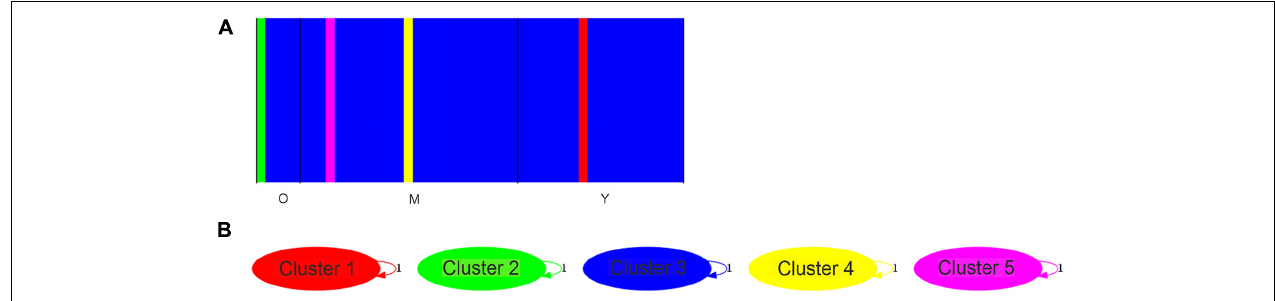
FIGURE 7 | (A) Bar plot from the Bayesian clustering analysis of individuals from three generations of M . argun ; O assigned for old, M for middle-age, and Y for young individuals. Bar plot for a K = 5 model based on SNP markers. (B) A gene flow network identified for the five clusters ( K = 5) as obtained by BAPS based on SNP markers. Weighted arrows indicate relative average amounts of ancestry coming from the source cluster but present now among individuals assigned to the target cluster. However, no gene flow was detected. Cluster 1 = individual YS2–40, Cluster 2 = individual MS1–11, Cluster 3 = individual YS2–20, Cluster 4 = individual OS1–1, and Cluster 5 includes other 45 individuals belonging to different generations from both sites.